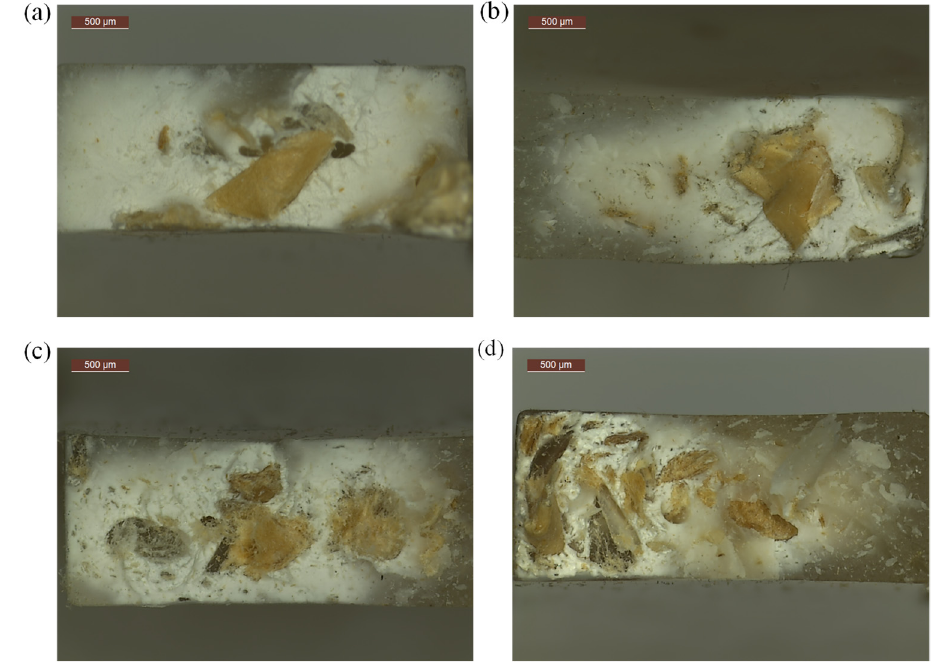
Figure 7. Microscopic photos of the cross-sections of ( a ) P_1_3, ( b ) P_1_2, ( c ) P_1_1, ( d ) P_2_1 sam- ple.